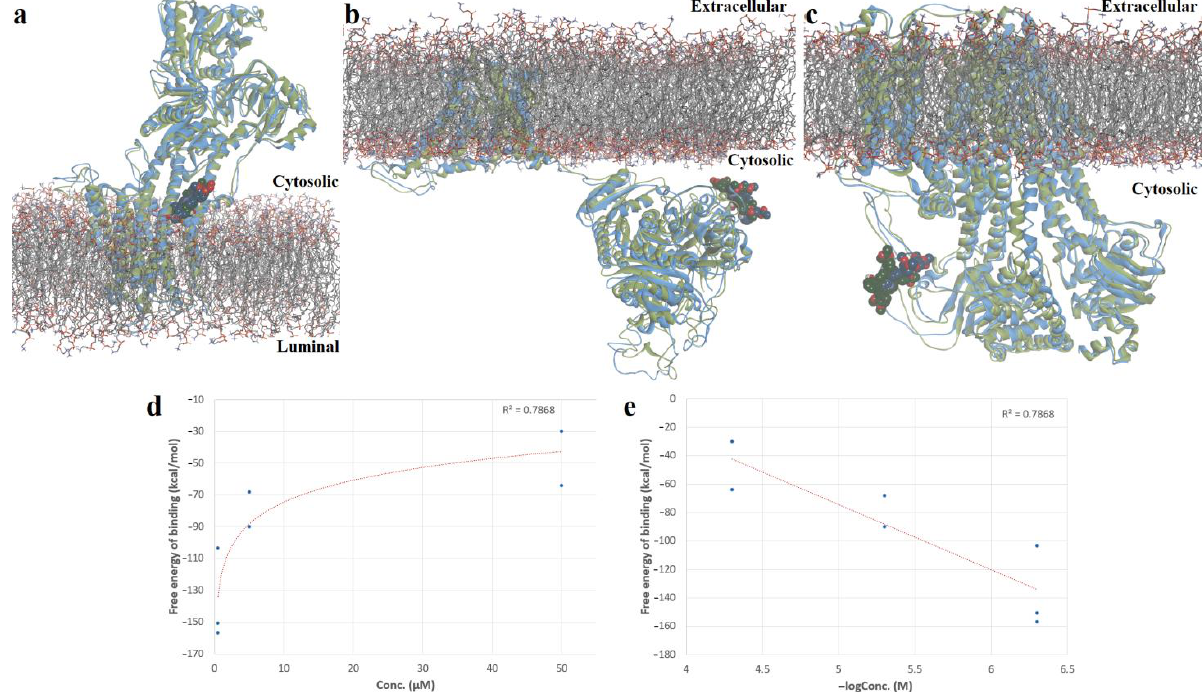
Figure 11. ( a ) — Superposition of simulated conformation (green) of Cu(II)TMAPOHo-SERCA2b complex on original structure (blue); ( b ) — superposition of simulated conformation (green) of Cu(II)TMAPOHo-Slo1 complex on original structure (blue); ( c ) — superposition of simulated conformation (green) of Cu(II)TMAPOHo-SUR2 complex on original structure (blue); ( d ) — exponential relationship between free binding energy values and tested porphyrin concentrations; ( e ) — correlation diagram between free binding energies and negative logarithmic values of tested porphyrin concentrations. Solvent molecules are hidden for clarity.